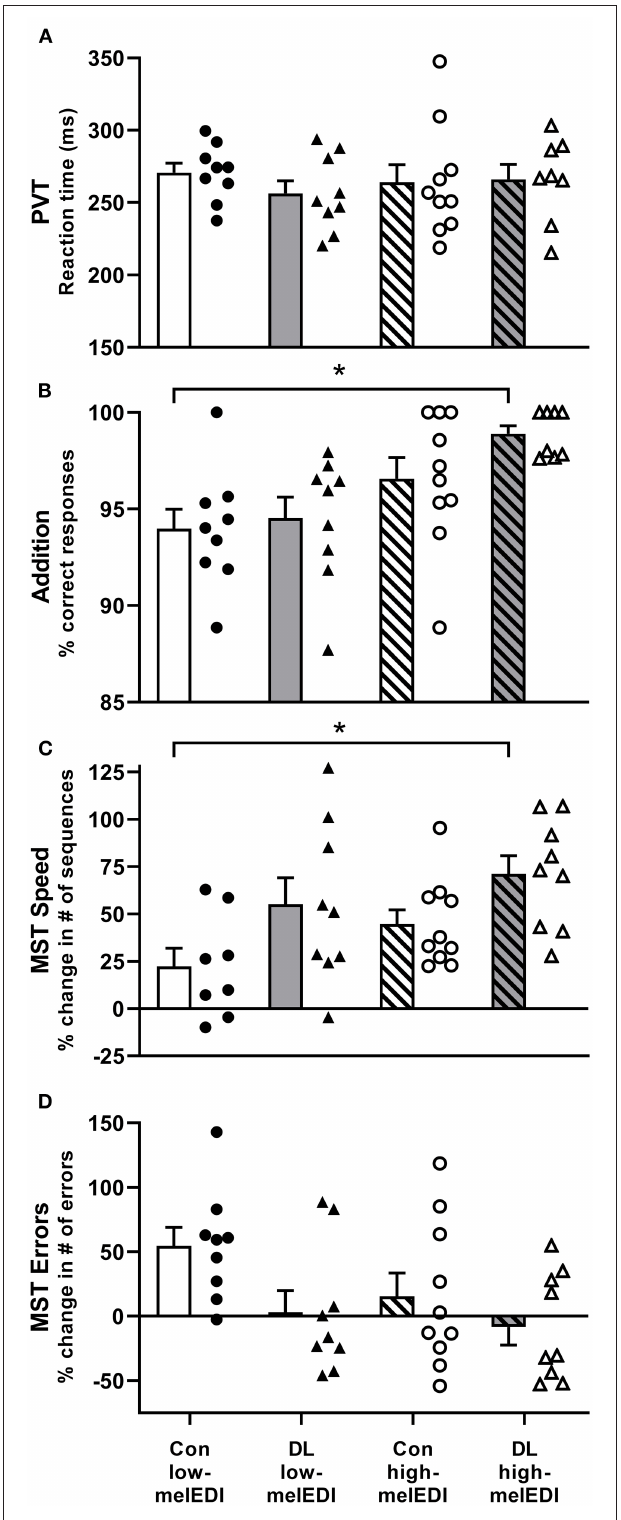
FIGURE 2 | Performance on the PVT, addition task, and motor sequence task for each light exposure condition. Mean